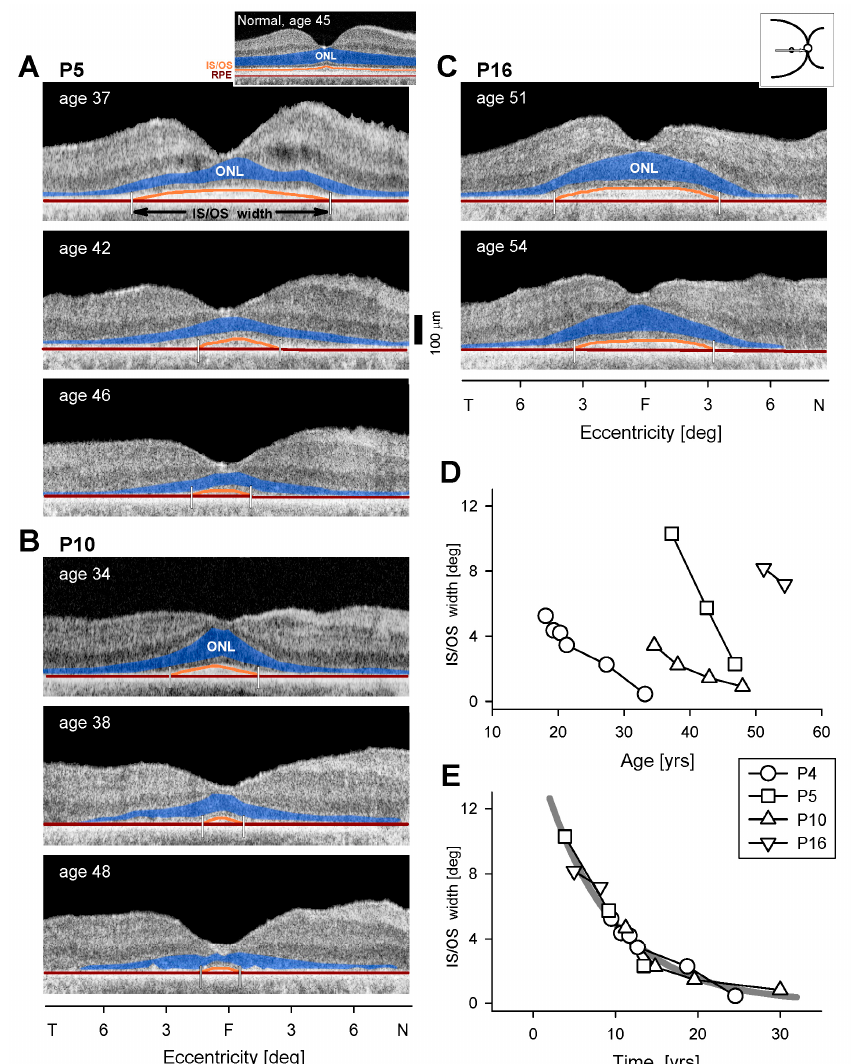
Figure 4. Serial changes in central retinal structure in EYS . ( A – C ) OCT scans along the horizontal meridian through the fovea in three EYS patients. ONL is colorized in blue and proximal edges of the inner segment/outer segment (IS/OS) band and retinal pigment epithelium (RPE) used for segmentation are colored in orange and dark red, respectively. Small vertical lines mark endpoints of IS/OS width. Inset above ( A ) shows a normal central retina, also with colorizing of ONL, IS/OS and RPE. ( D ) IS/OS width plotted as a function of age for four patients; serial data connected by lines. Note: symbols in D and E are the same and identified in the key between the two graphs. ( E ) Longitudinal measurements of IS/OS width from each patient are shifted along the time axis to fit the model of exponential decay; the rate is 12% per year (thick gray